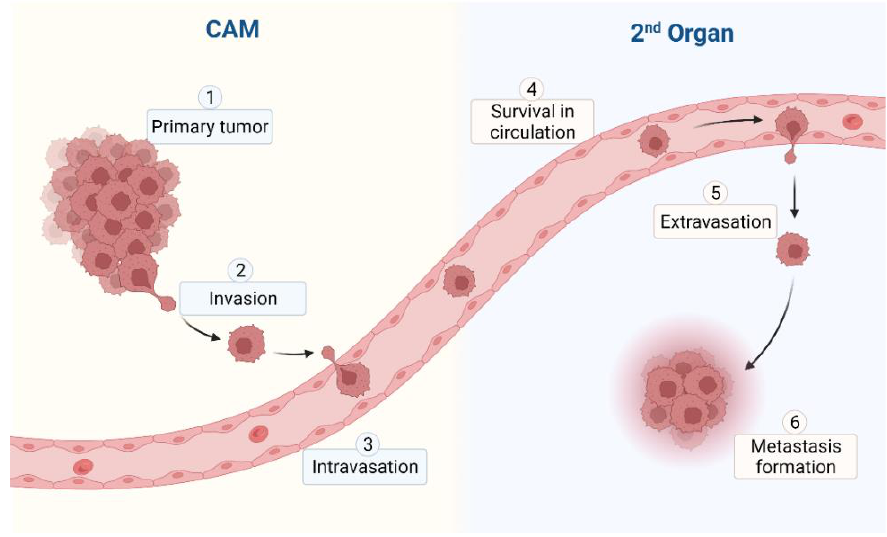
Figure 3. Metastatic cascade in the CAM model.